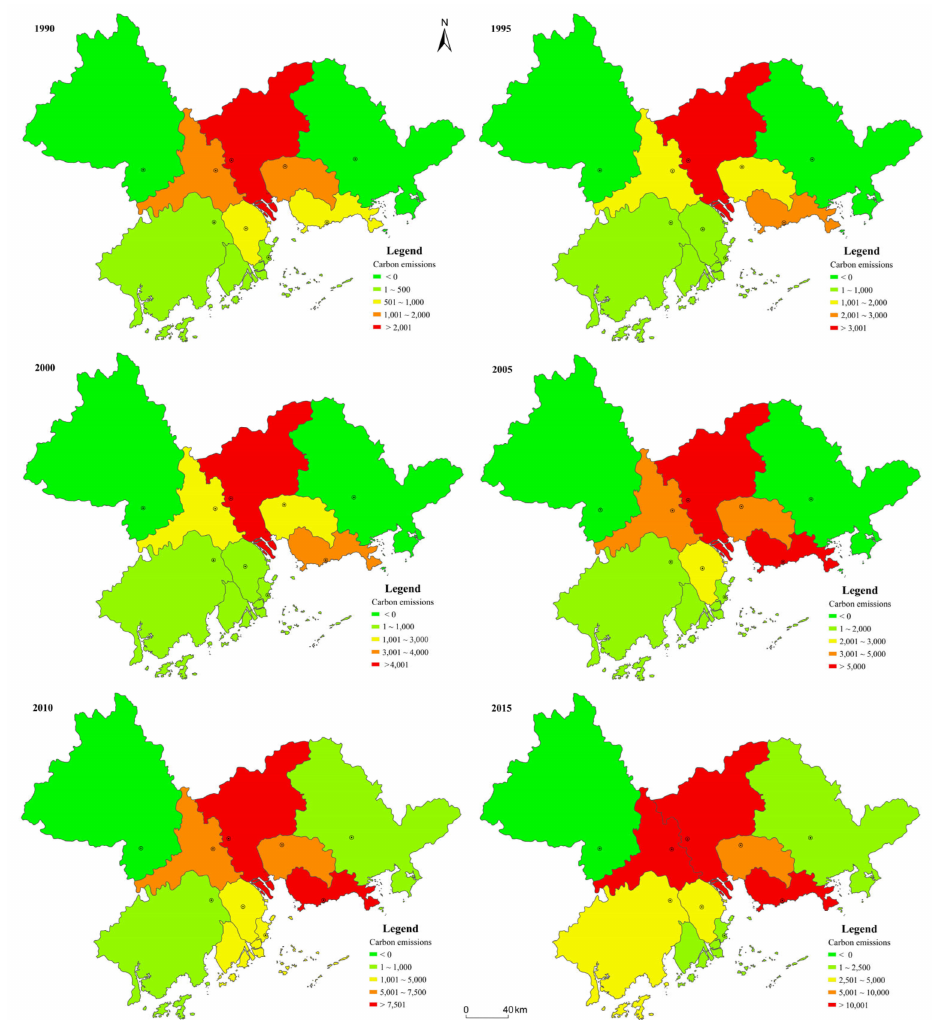
Figure 4. Spatiotemporal changes in land-use-related carbon emissions in the PRD (10 4 t